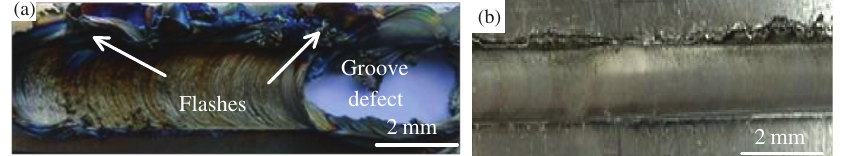
Figure 1: Surface appearances of 2mm thick joints: (a) 475 rpm/50mm/min and (b) 120 rpm/30mm/min.